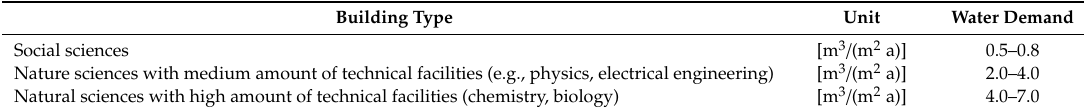
Table 5. Water demand per square meter and year in buildings for educational purposes. Source: